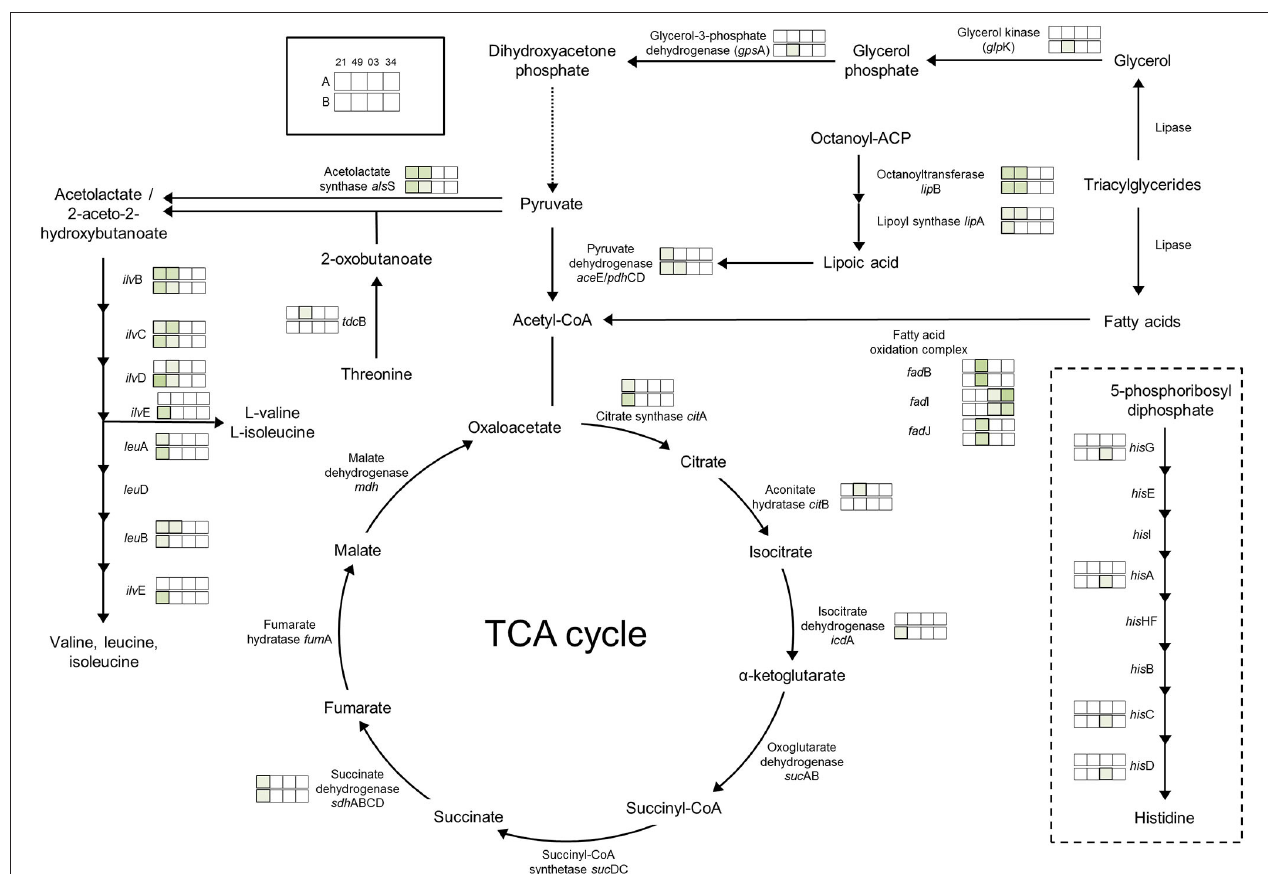
FIGURE 3 | Regulation of enzymes observed under aerobic conditions. The colored boxes display the observed regulation for each strain. Each row of the colored boxes corresponds to one comparison: A. air_vs._N 2 , B. O 2 N 2 _vs._N 2 . Each column of the colored boxes corresponds to one strain: P. carnosum 21 = TMW 2.2021 T , 49 = TMW 2.2149, P. phosphoreum 03 = TMW 2.2103, 34 = TMW 2.2134. Color code is represented